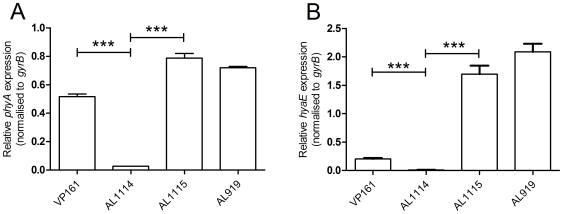
Relative expression of phyA and hyaE in four P. multocida strains.The expression levels of phyA (panel A) and hyaE (panel B) were determined for the strains VP161 (wild-type), AL1114 (spontaneous acapsular strain), AL1115 (paired capsulated strain) and AL919 (a VP161 hyaB insertional mutant) by qRT-PCR and normalized to the level of gyrB expression. The average relative expression was determined from three biological replicates and the values shown are the mean ±1 SEM. ** p<0.01, * p<0.05.